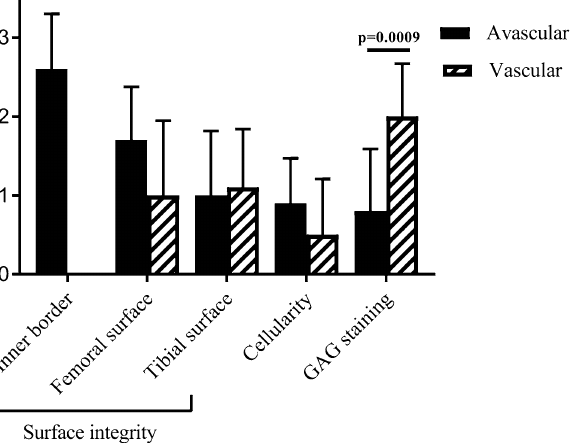
Figure 1. Histological grading results of avascular and vascular regions of the meniscus based on three scoring parameters (n = 10). The glycosaminoglycan (GAG) staining intensity in the vascular region was significantly higher than in the avascular region; (Grade 1: 0–3; Grade 2: 4–7; Grade 3: 8–11; Grade 4: 12–15). Data shown are the means ± the standard deviation.